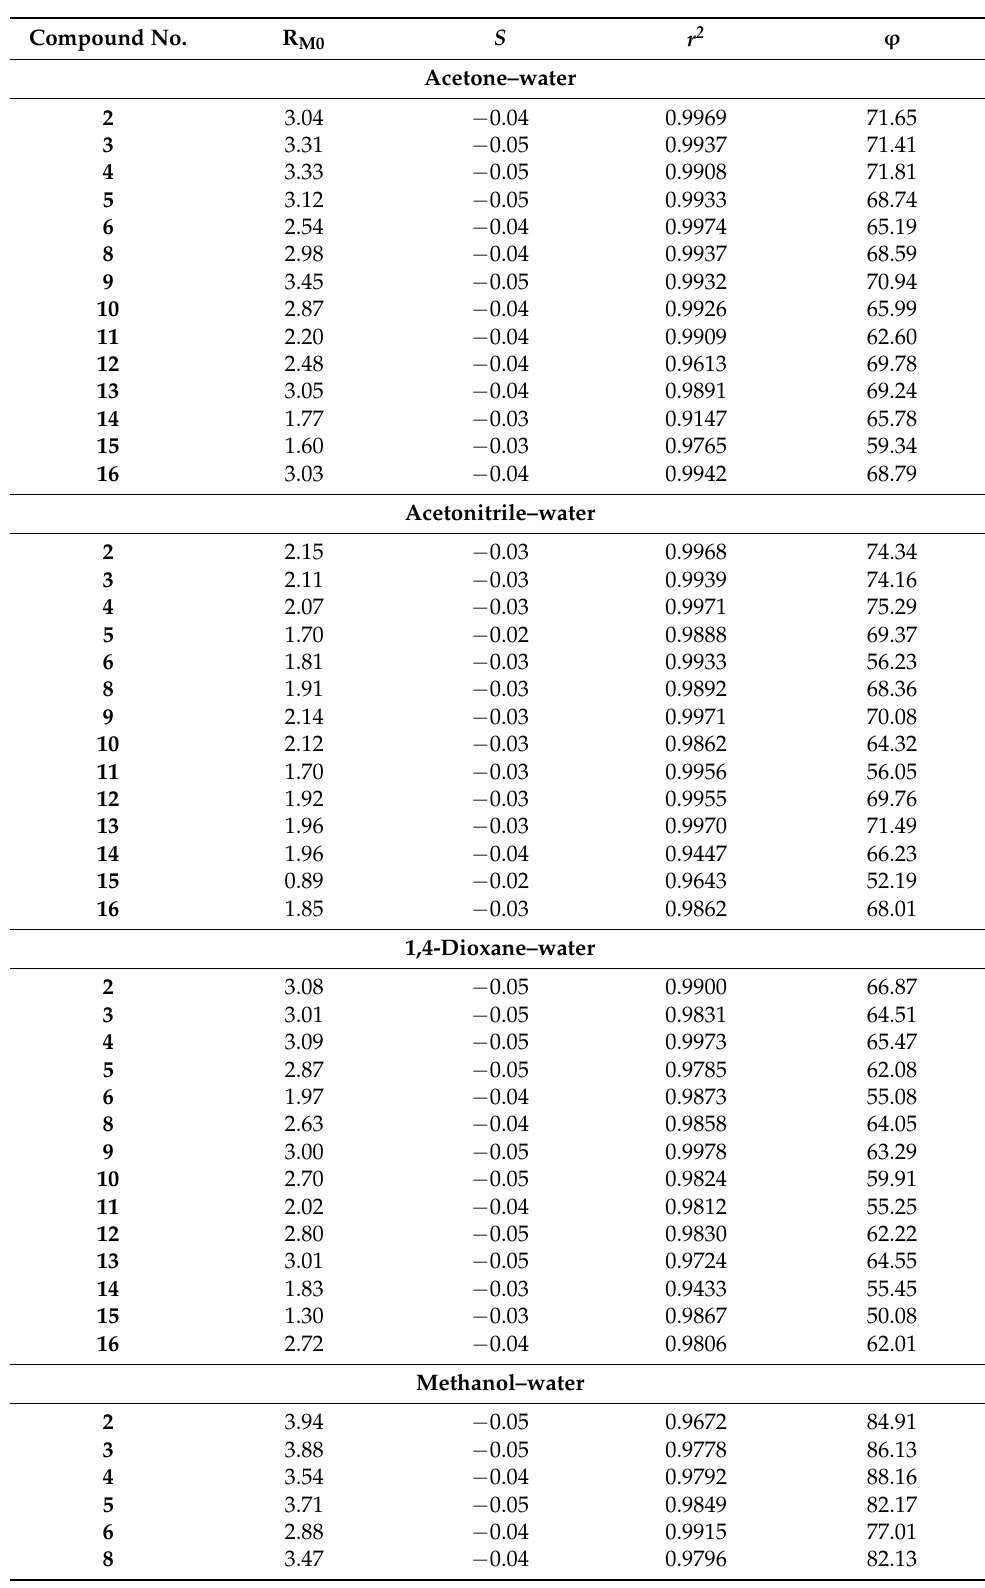
Table 2. The R M0 values of the synthesized 4-methyl-1,2,3-thiadiazole-5-carbooxylic acid derivatives ( 2 – 6 and 8 – 16